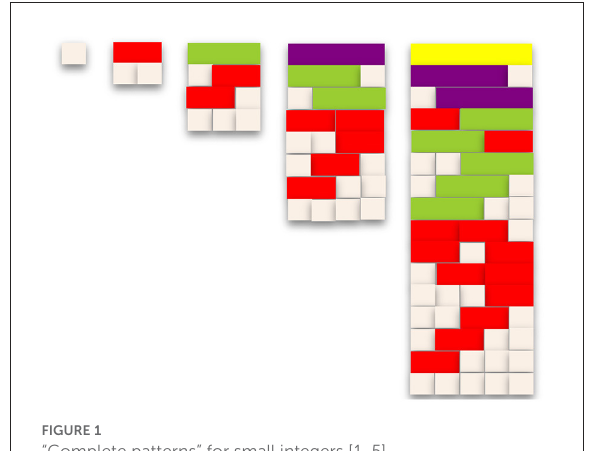
FIGURE1 “Complete patterns” for small integers